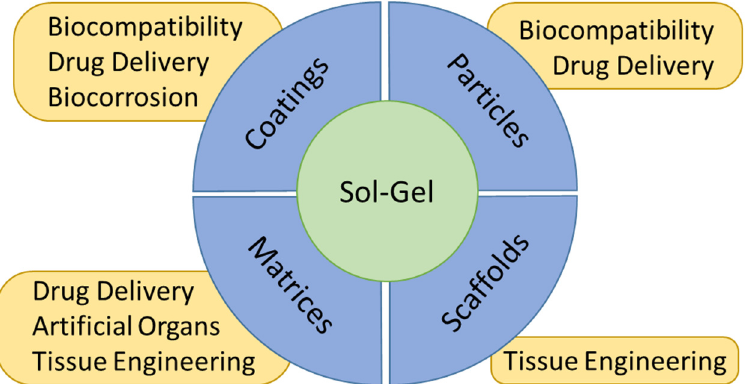
Figure 3. Generation of scaffolds for tissue engineering applications from the sol-gel synthesis process.